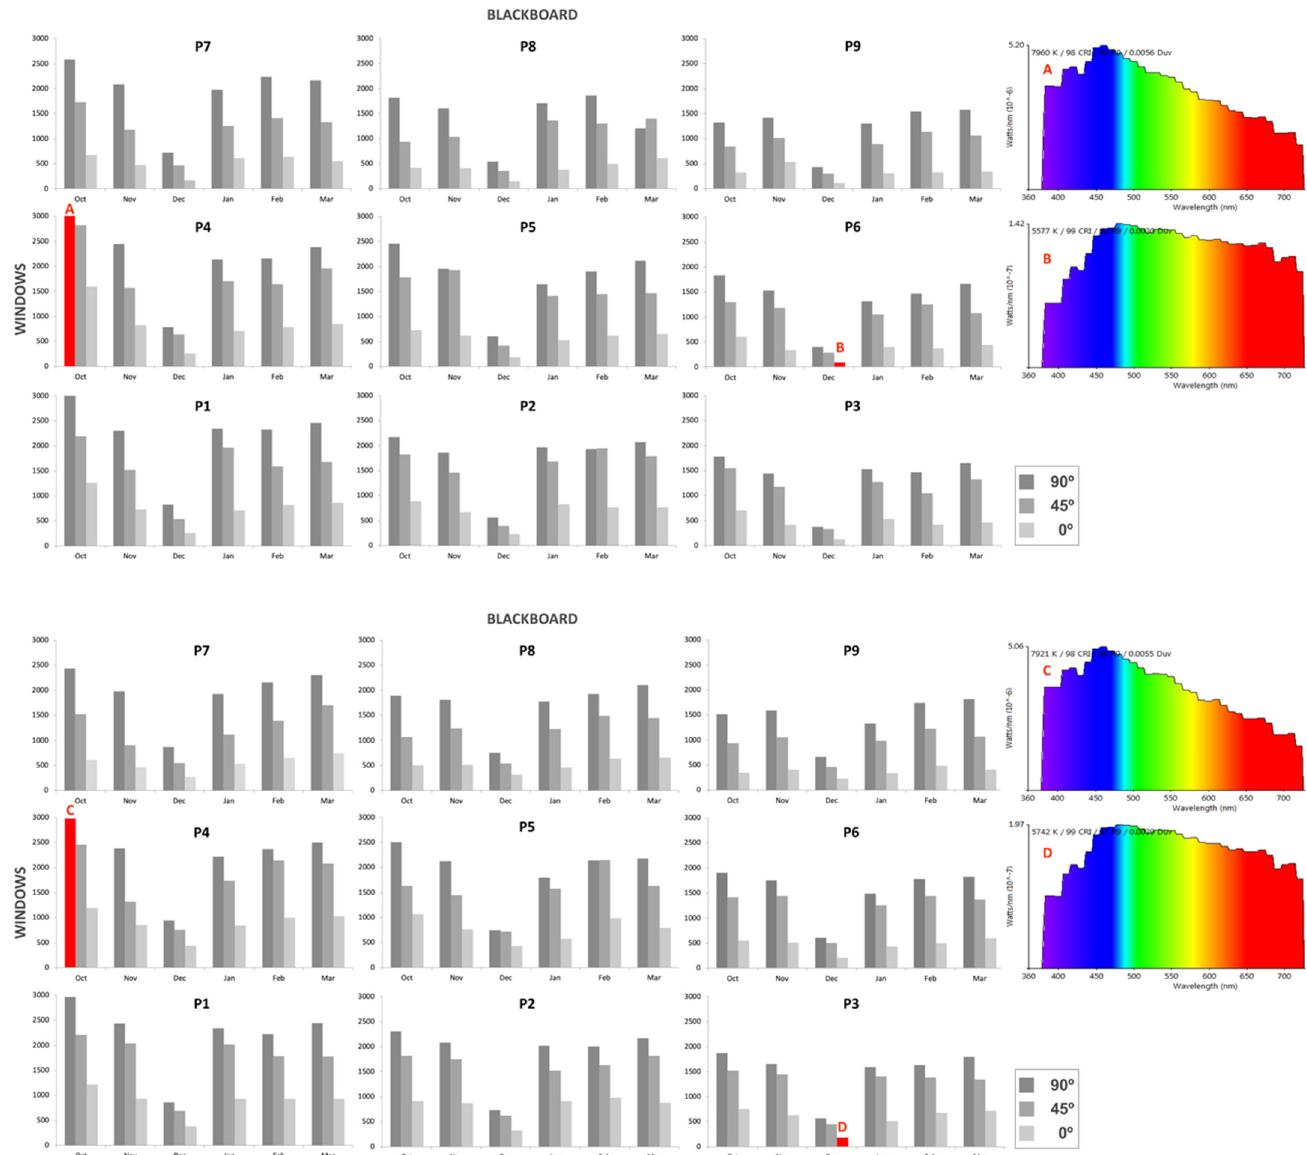
Figure 5. Classroom 2. Melanopic values according to the CIE standard (EDI melanopic lux) acting, in upper figure daylighting in Classroom 2 at each point (P1, P2, P3, P4, P5, P6, P7, P8 and P9) and in the three gaze orientations (0 ◦ , 45 ◦ and 90 ◦ ); in lower figure, daylighting + artificial lighting in Classroom 2 at each point (P1, P2, P3, P4, P5, P6, P7, P8 and P9) and in the three gaze orientations (0 ◦ , 45 ◦ and 90 ◦ ). Right figures, SPD of ( A ) maximum daylighting in the month of October at Point 4 with 90 ◦ orientation; ( B ) minimum daylighting in December at Point 6 with orientation at 0 ◦ ; ( C ) maximum daylighting + artificial lighting in the month of October at Point 4 with 90 ◦ orientation; ( D ) minimum daylighting + artificial lighting in the month of December at Point 3 with orientation at 0 ◦ . OsramColorCalculator was used to plot the SPDs.